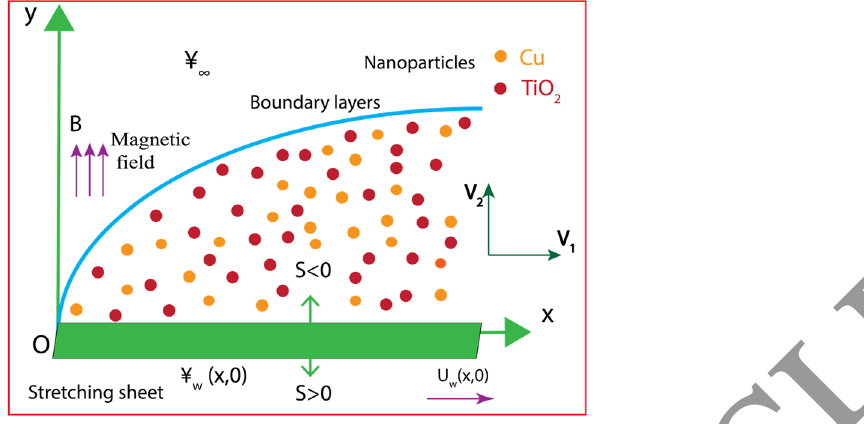
Figure 1. Diagram of the flow model.